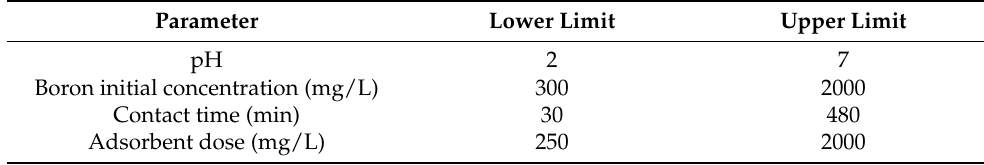
Table 1. Factor ranges in the Box–Behnken research setup.